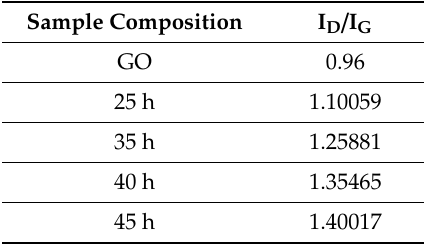
Table 1. Intensity ratio of defect and graphitic peak of grapheme